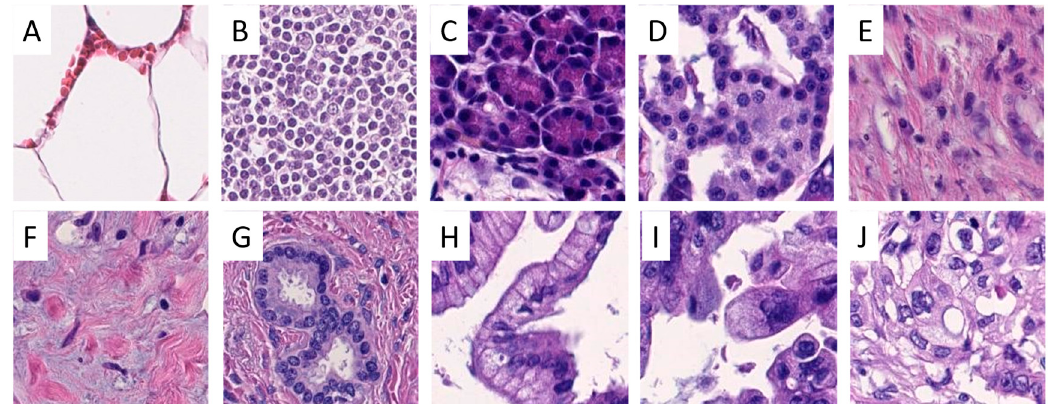
Figure 8. Examples of image patches from annotated areas. One representative image patch from fat ( A ), lymph node ( B ), exocrine ( C ) and endocrine parenchyma ( D ), stroma ( E ), tumor-associated stroma ( F ), normal pancreatic ducts ( G ), pancreatic intraepithelial neoplasia low-grade ( H ) and high-grade ( I ), and pancreatic ductal adenocarcinoma ( J ) is shown. Lymph node metastasis from pancreatic adenocarcinoma is not displayed. Magnification: each image 100 × 100 µ m (219 × 219 px).